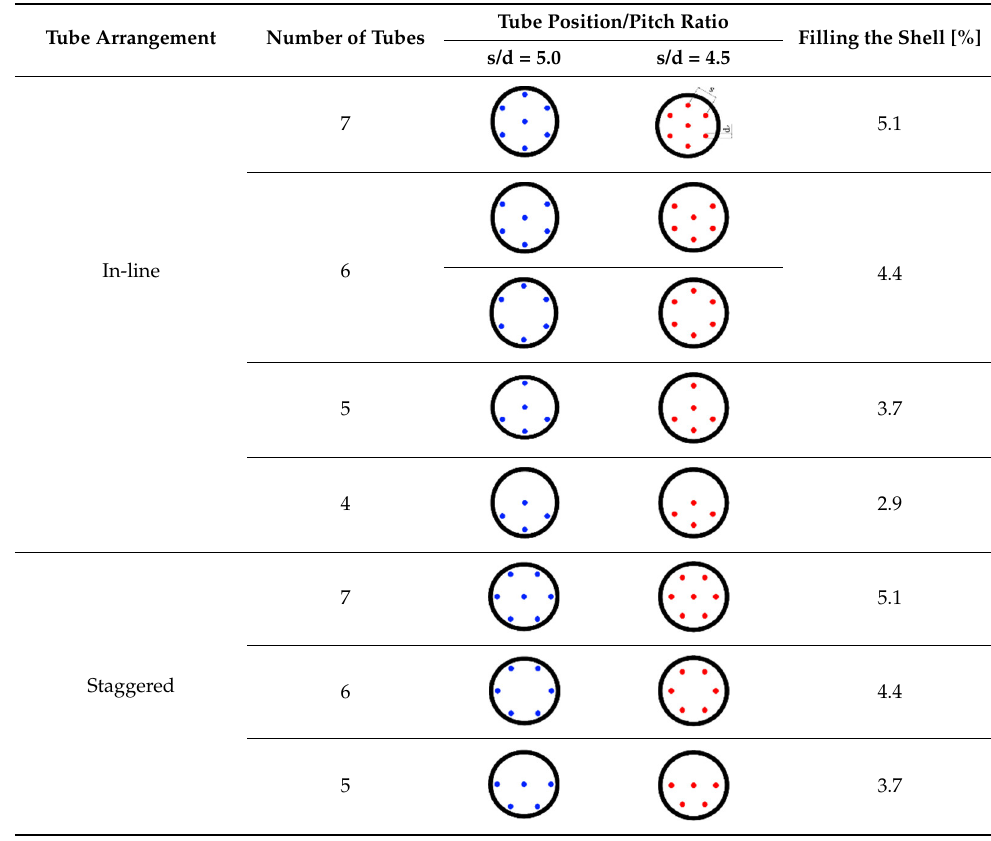
Table 1. Tested tube arrangements.